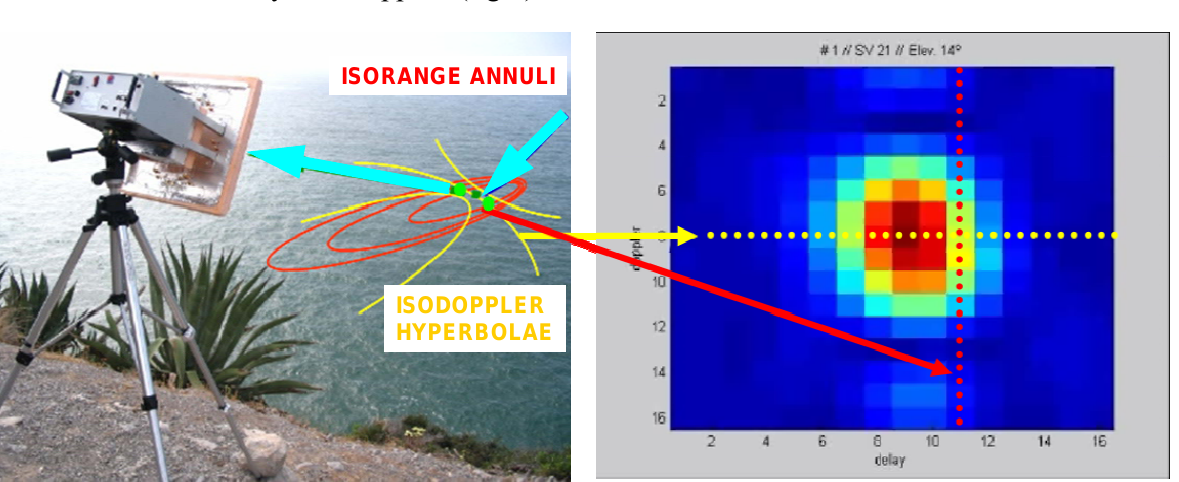
Figure 3. (left) GNSS-R geometry of observation from Garraf coast (South of Barcelona). Red: isorange annuli (same delay), Yellow: isoDoppler hyperbolae (same Doppler), Green dots with same delay and Doppler. (right) measured DDM.